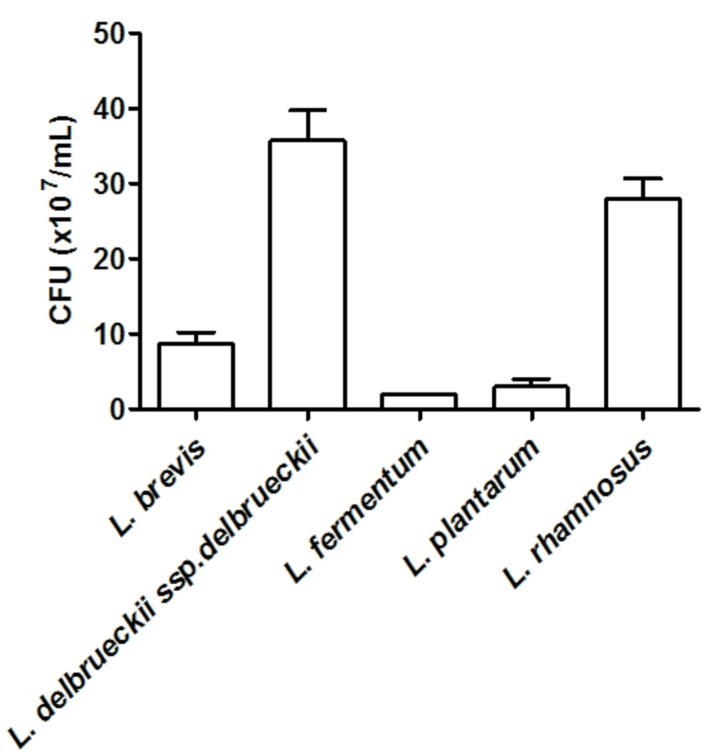
Quantification of the adhesion of Lactobacillus (~2.3 × 106 CFU) strains to HeLa cells. The values are expressed in CFU/ml and represent the means of the values obtained. The assay was performed in triplicate.